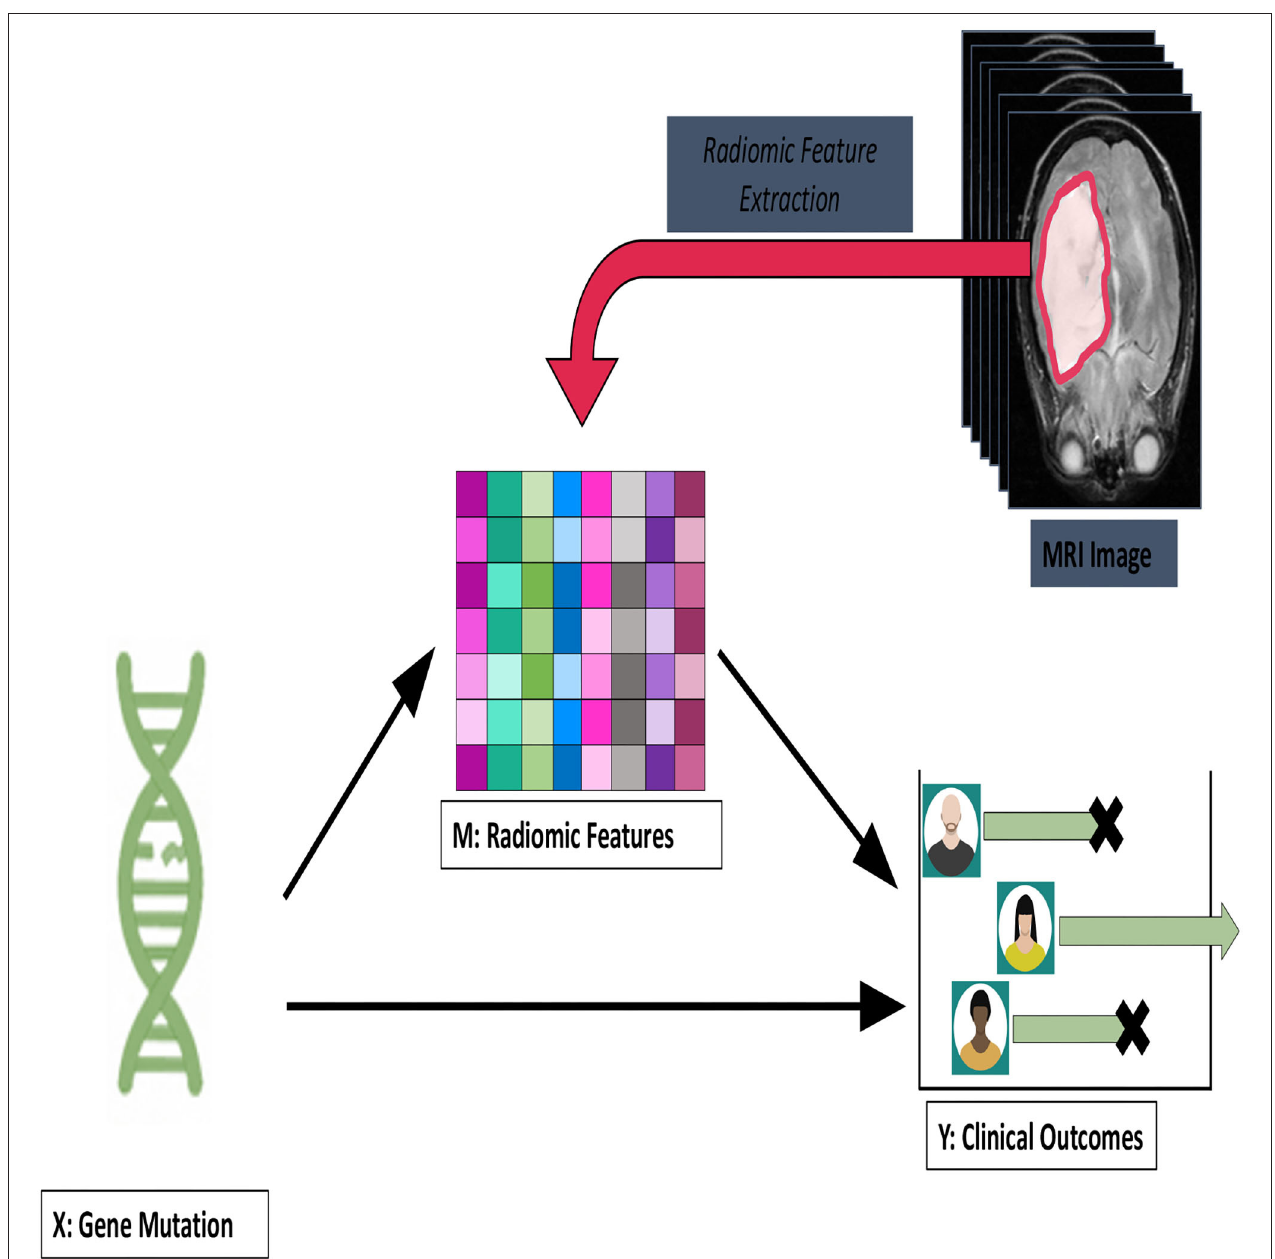
FIGURE 3 | A framework for viewing the radiomics measurements as mediation variables. The exposure here is a DNA mutation which leads to tumorigenesis that is captured by the imaging and radiomics feature and which leads to a clinical outcome.